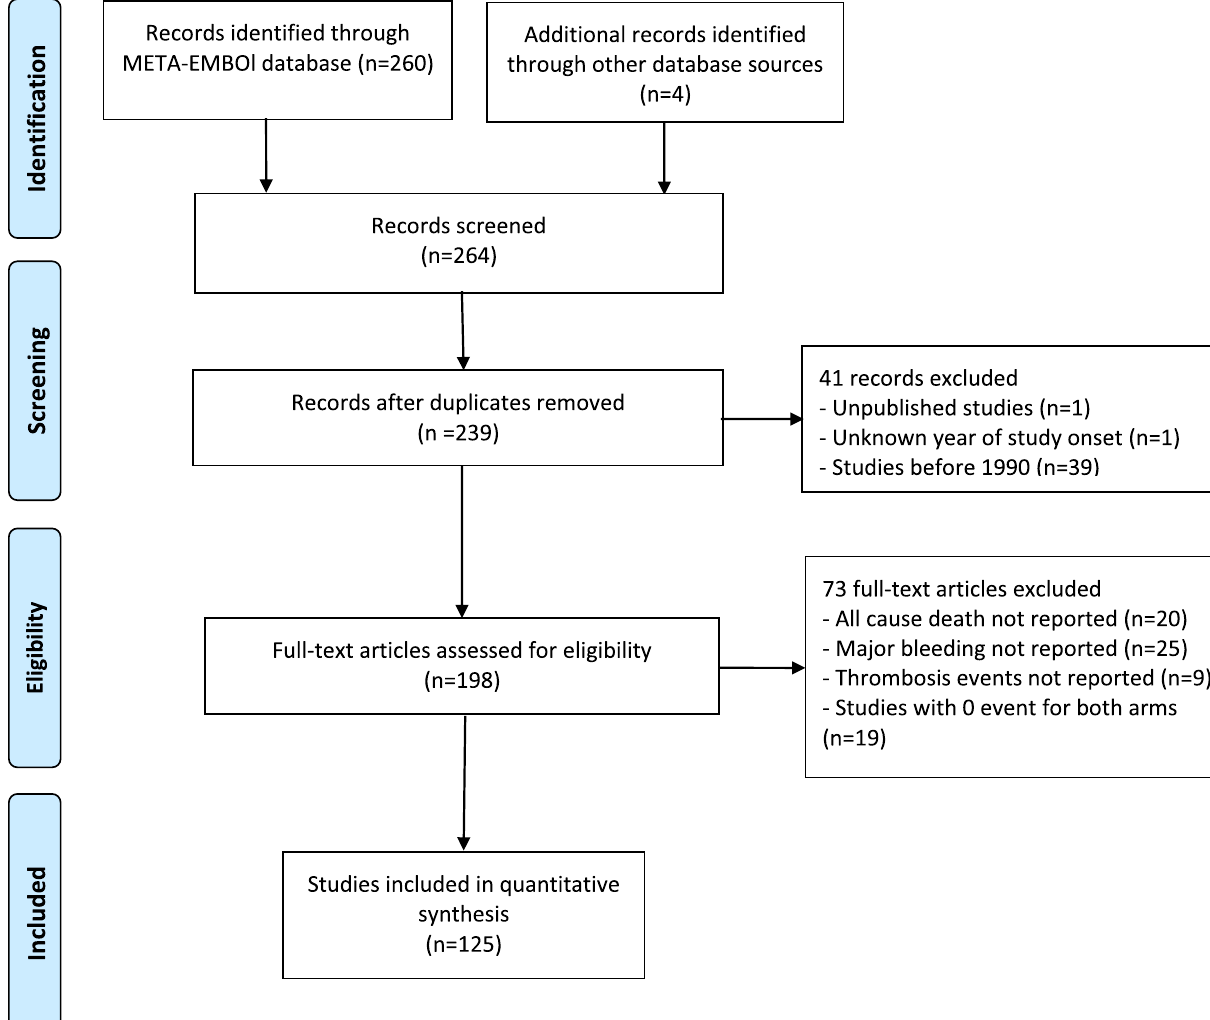
Figure 1. PRISMA flowchart. NCB, net clinical